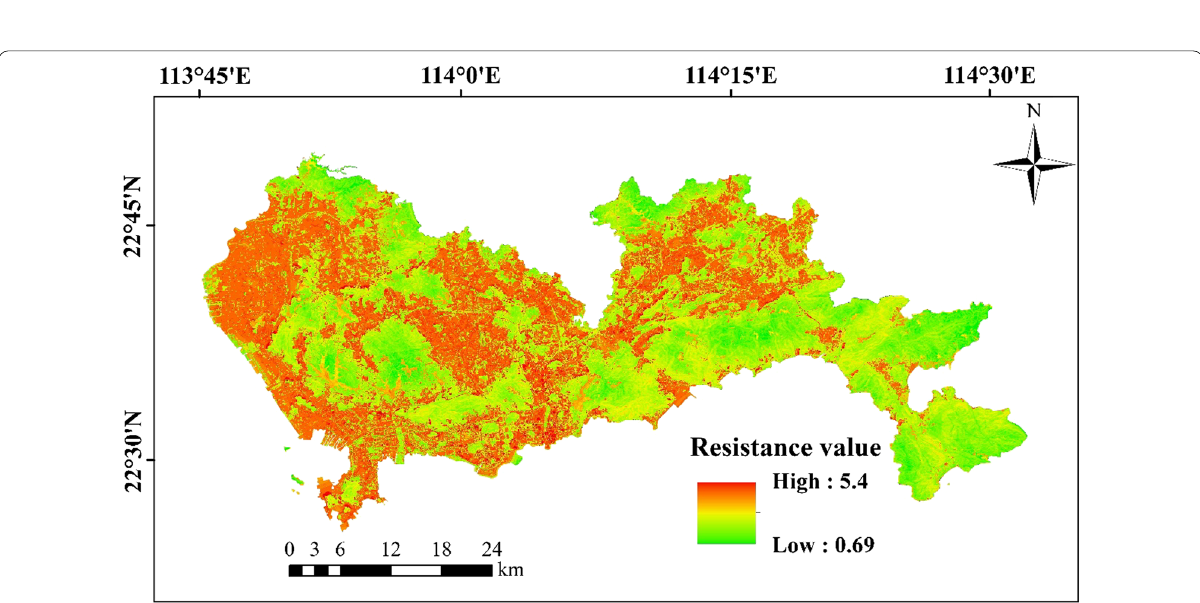
Fig. 5 Ecological resistance surface of the study area. The color from green to red denotes the resistance value ranging from low to